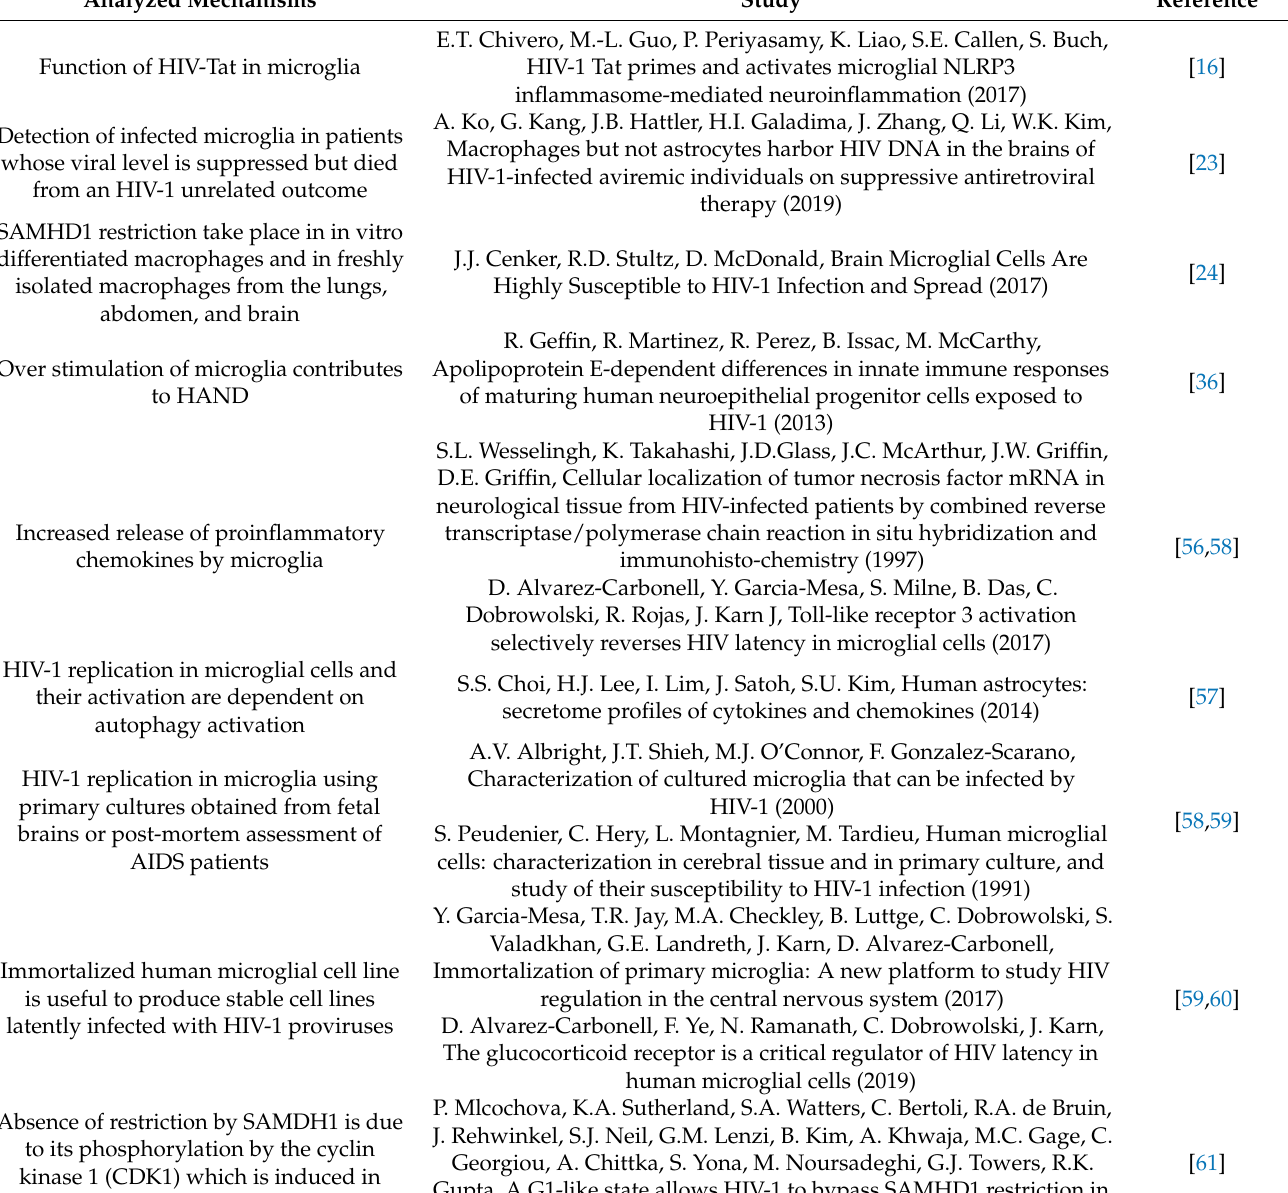
Table 1. Studies about mechanisms in microglial